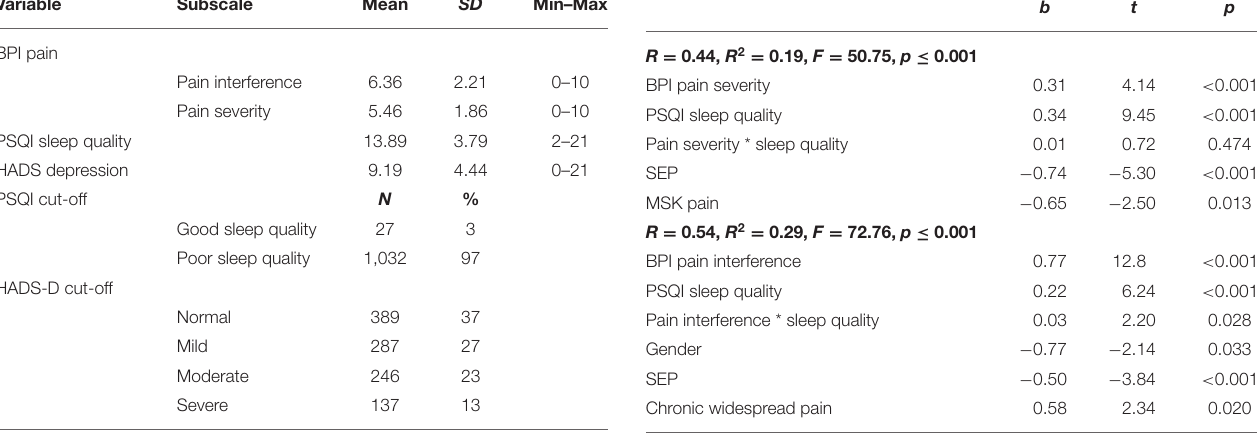
Bold text displays results from the moderated multiple regression